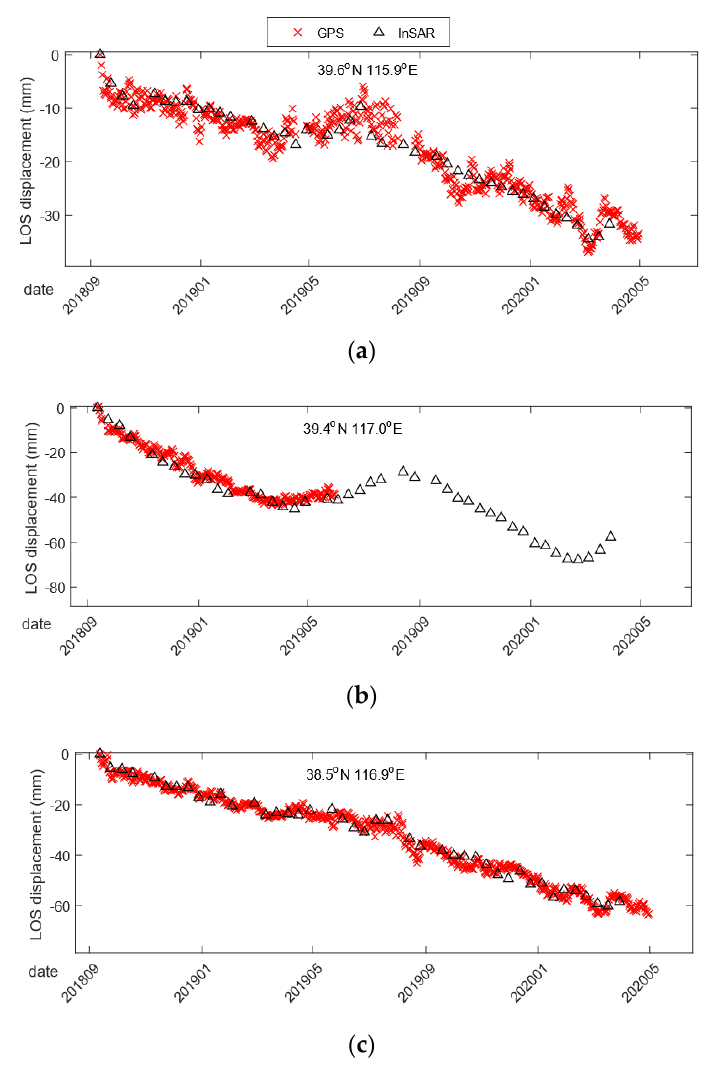
Figure 14. GNSS displacement time series in the LOS direction (red stars) compared with InSAR time series (black triangles) for the three GNSS stations ( a – c ), respectively. The geographical locations of three GNSS stations are in the top middle of the